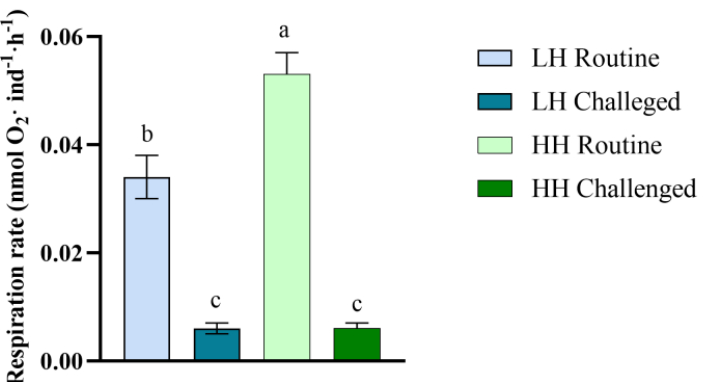
Figure 3. Effect of diets with low (LH) and high (HH) HUFAs on the respiration rate of veliger larvae of the scallop Argopecten purpuratus under unchallenged (routine) and Vibrio splendidus (VPA18)- challenged conditions. Different lowercase letters indicate significant differences between treatments ( p < 0.05); n = 6 pools per condition .